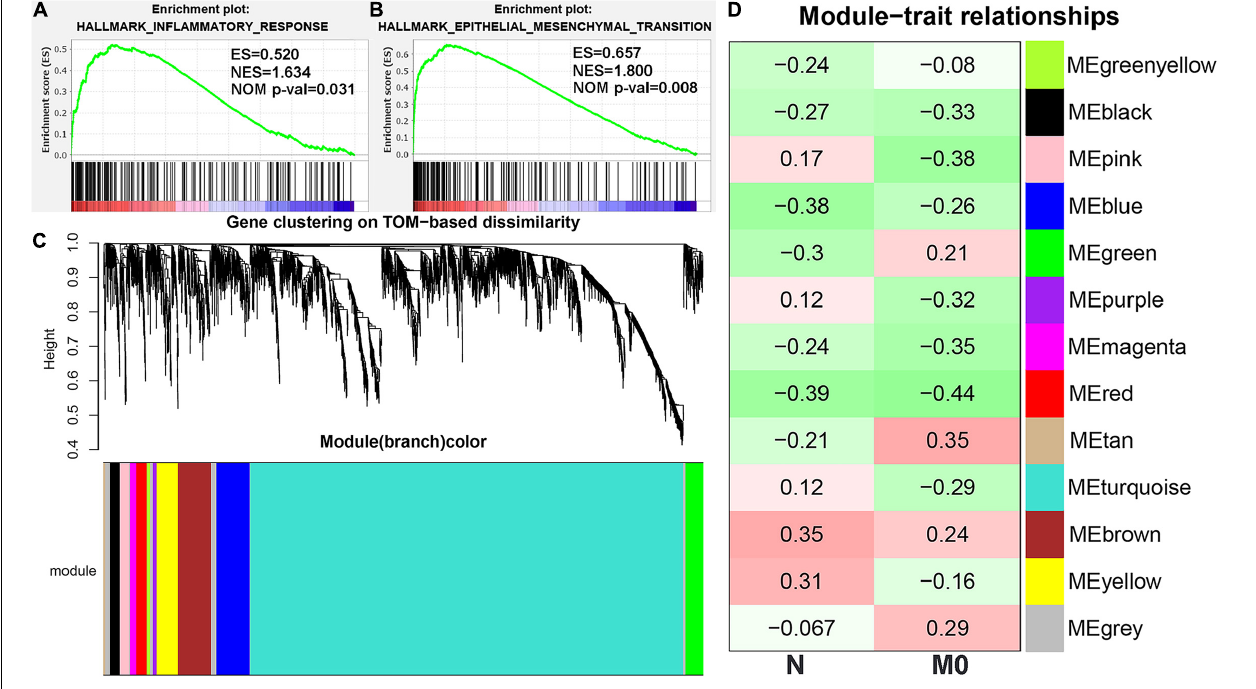
FIGURE 2 | Identification of mRNA modules associated with lymph node metastasis and M0 infiltration. Gene set enrichment analysis (GSEA) suggested that early lymph node metastasis was related to the inflammatory response (IR) pathway (A) , and the epithelial–mesenchymal transition (EMT) pathway were significantly enriched in the M0 high-infiltration group (B) . (C) The scale-free mRNA network was clustered into 13 modules by average hierarchical clustering and dynamic tree clipping. (D) The correlation heatmap was used to describe the relationship between 13 genesets and N stage, M0 infiltration. ES, enrichment score. NES, normalized ES. NOM p -val, normalized p -value. TOM, topological overlap